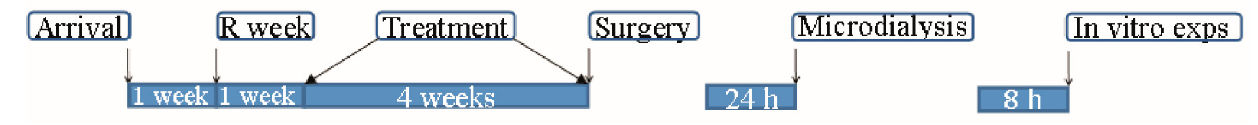
Figure 7. Experimental protocol. The diagram shows the various phases of the experimental protocol.